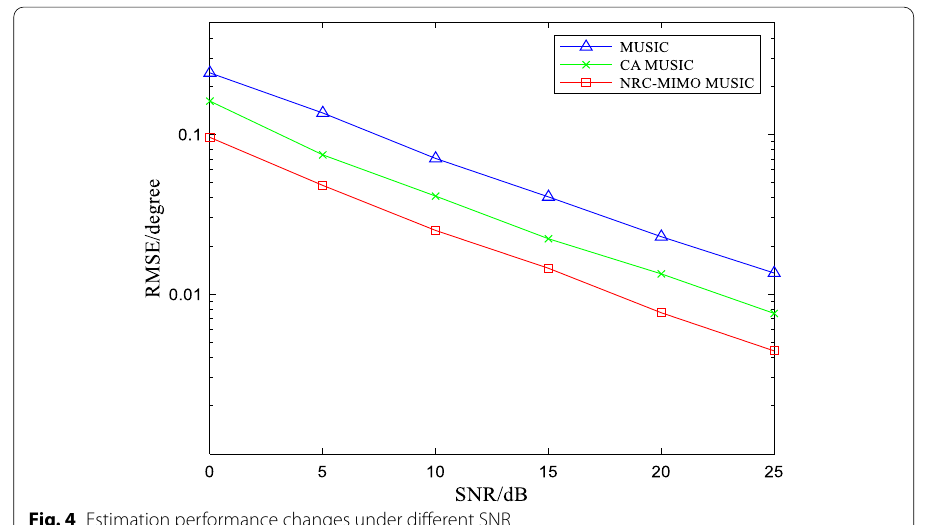
Fig. 4 Estimation performance changes under different SNR